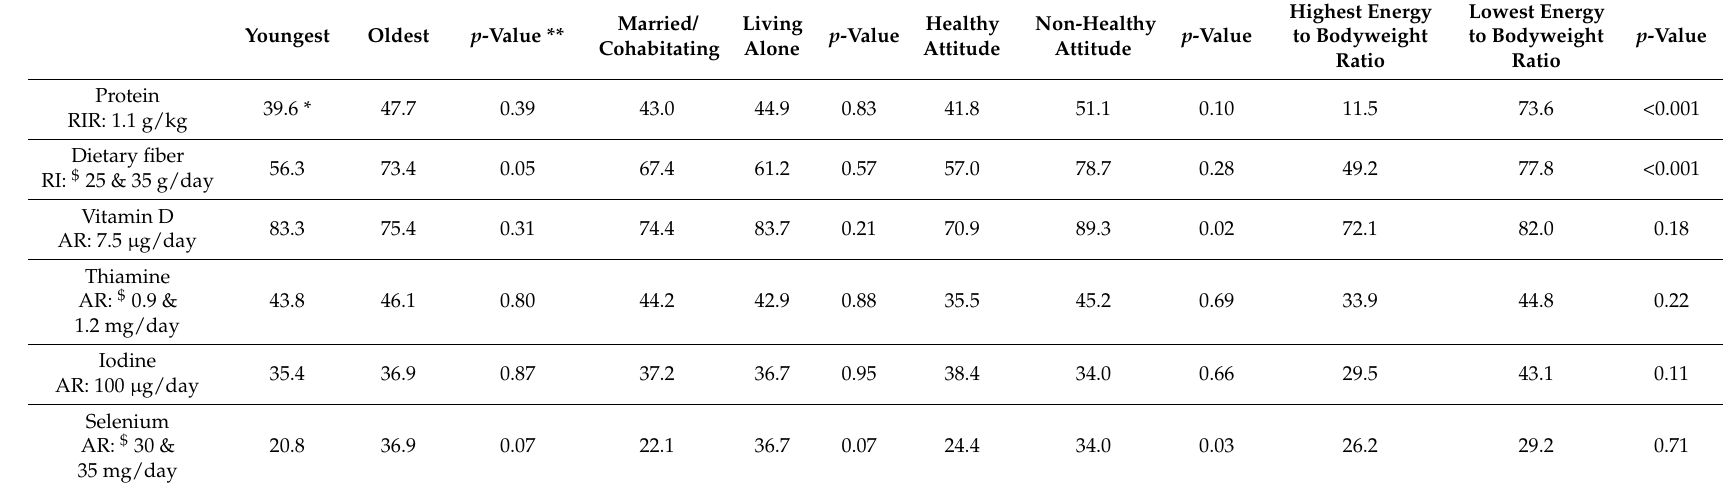
Table 5. Potential determinants of nutrient